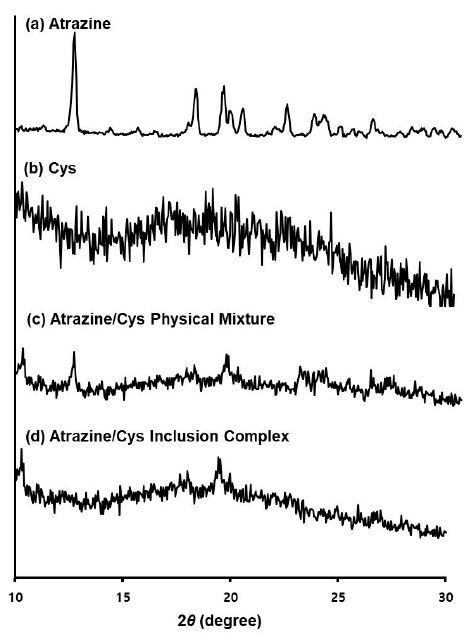
Figure 6. XRD analysis of ( a ) atrazine; ( b ) Cys; ( c ) atrazine/Cys physical mixture; ( d ) atrazine/Cys inclusion complex.